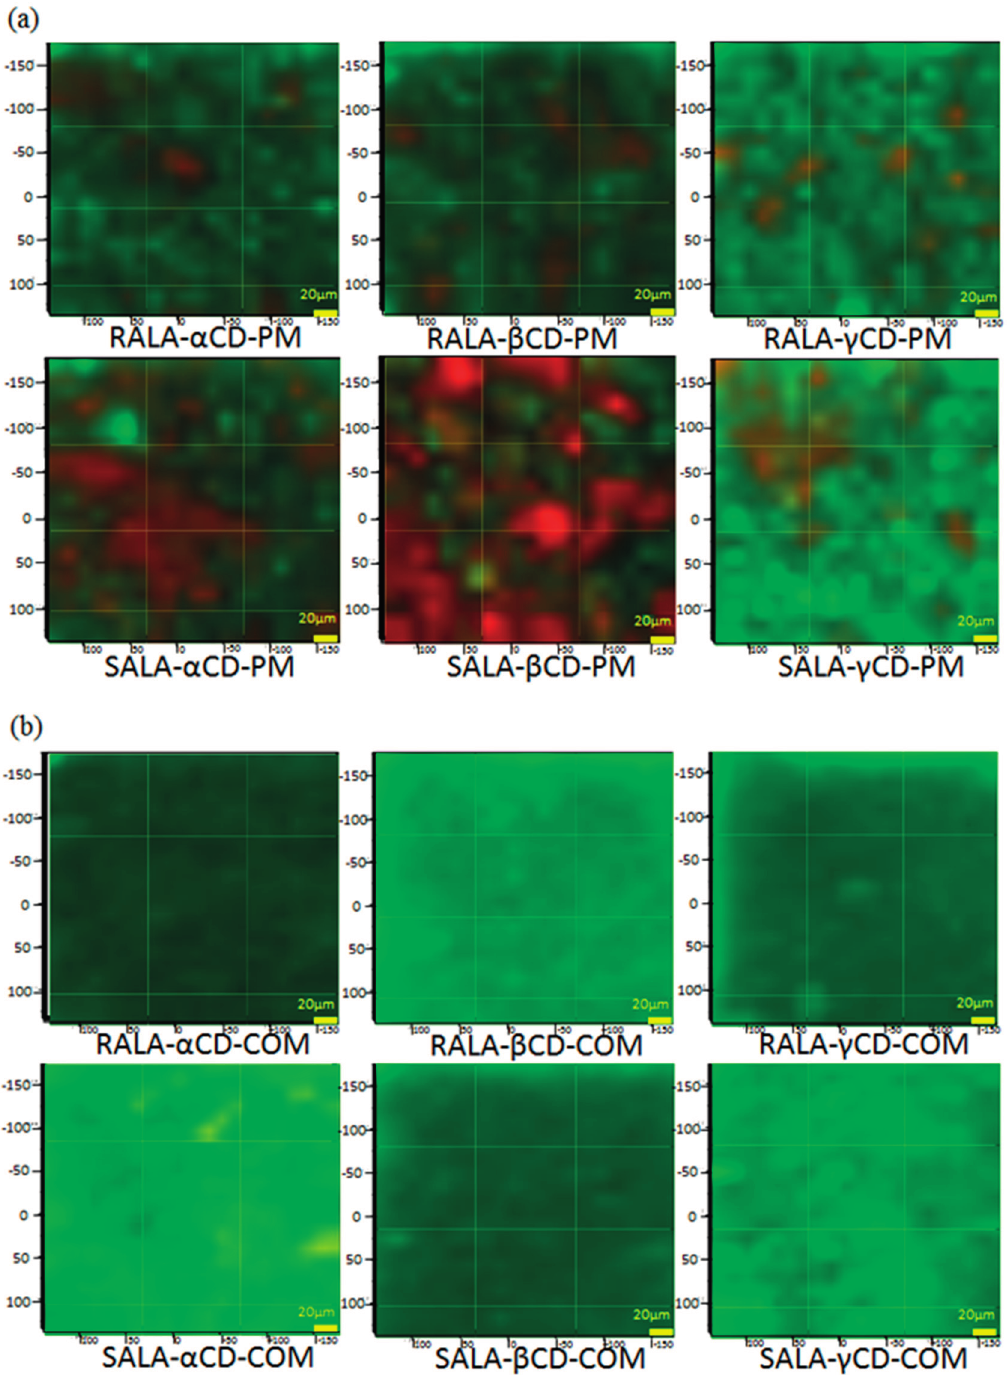
Figure 9. Raman chemical mapping of ( a ) the physical mixtures (PM) and ( b ) the complexes (COM). (Red: Lipoic acid, Green: